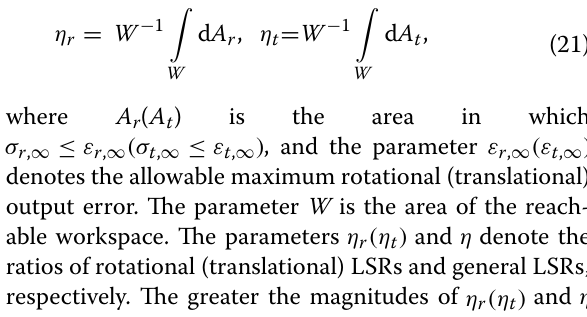
Figure 5 Distributions of RS and TS with ( r 1 , r 2 , r 3 , r 4 , z )